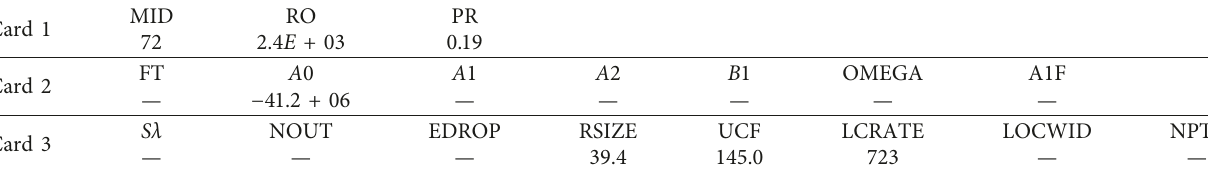
Table 6: ∗ MAT_CONCRETE_DAMAGE_REL3 constitutive model of concrete. Card